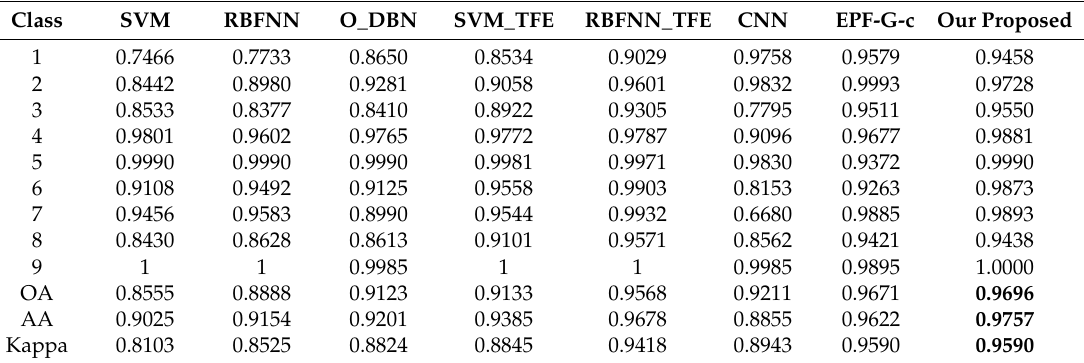
Table 8. Classification accuracy of different algorithms on University of Pavia.